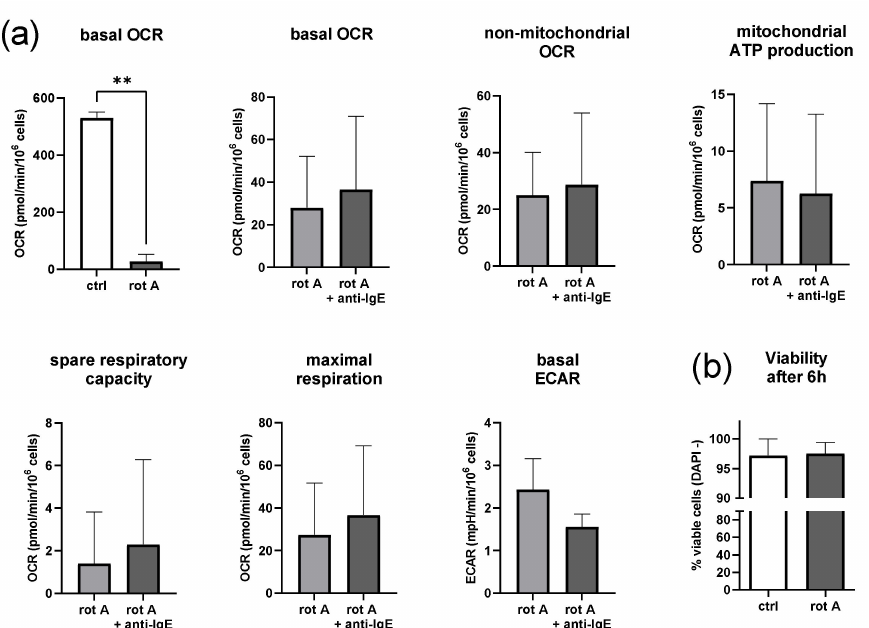
Figure 5. Inhibition of complex I of the respiratory chain reduces mitochondrial parameters and extracellular acidification but not the viability of human skin MCs irrespective of IgE-mediated activation. ( a ) Inhibition of complex I of the respiratory chain in human skin MCs using myxothiazol (myx) under glucose-free conditions reduced mitochondrial parameters rate (ECAR). It blocked an increase in the oxygen consumption rate (OCR) after IgE-mediated activation. ( b ) Human skin MC survive (DAPI -) substantial metabolic restriction (a and b: n = 3; mean ± SEM, paired Student’s t -test: ** p < 0.01), ctrl = vehicle control (1% v/v